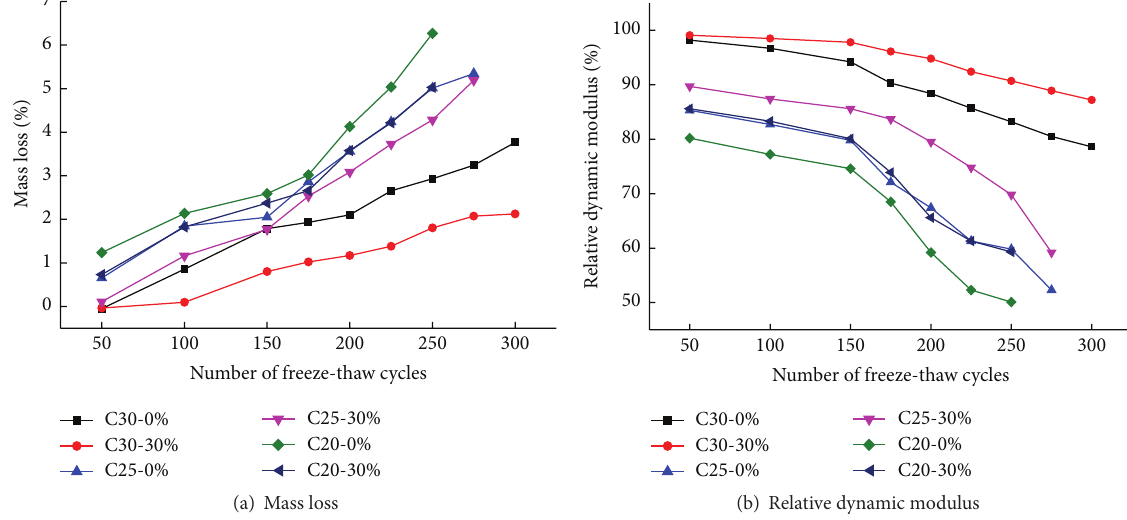
Figure 9: The antifrost performances of different strength concretes under water freeze-thaw test.